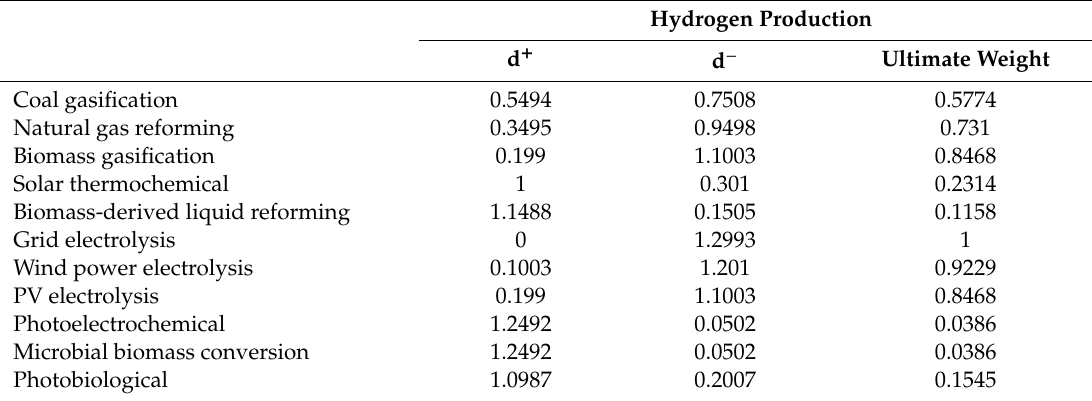
Table A5. Distance from FPIS and FNIS, and ultimate weights of hydrogen